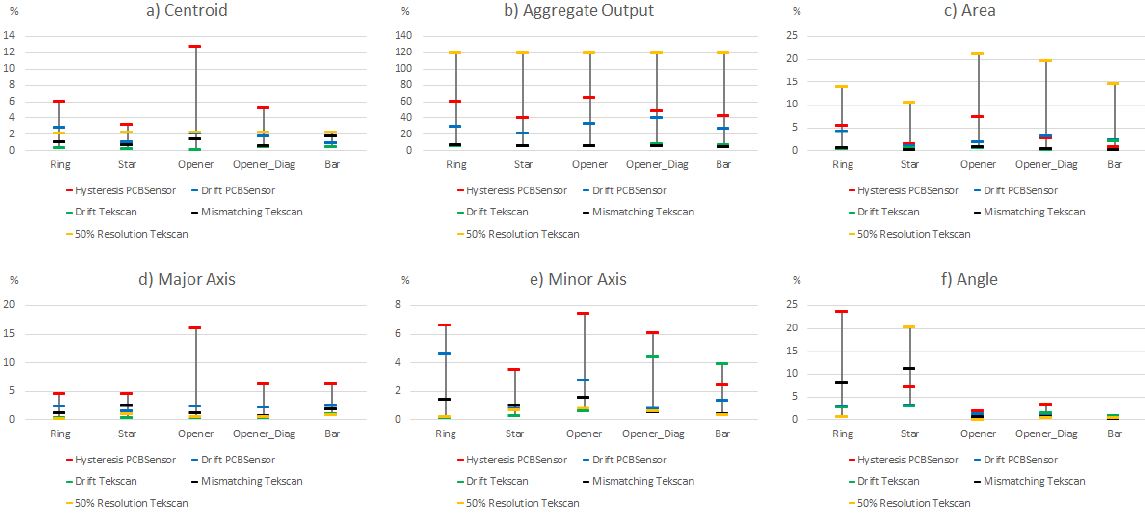
Figure 15. Comparison of the influence of different non idealities on the parameters of Table 4 (maximum